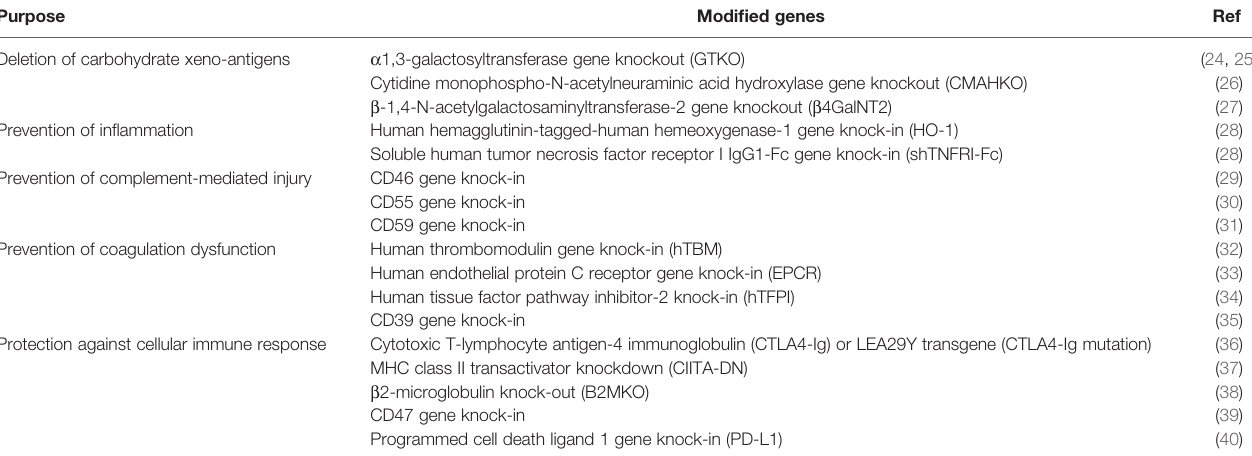
TABLE 3 | Selected gene modi fi cations in pigs of relevance to pig-to-NHP islet xenotransplantation.